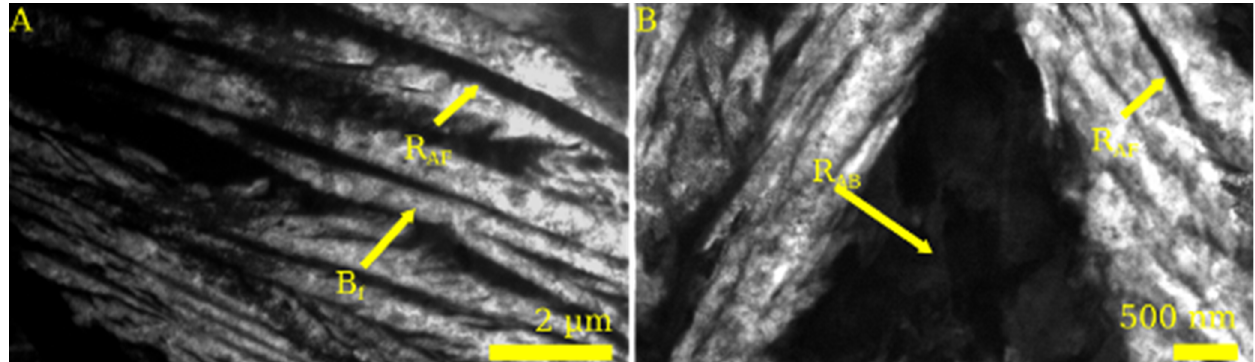
Figure 8. TEM micrographs on the samples treated according to MULTISTEP3 route ( A ) Bainitic sheave, ( B ) Retained austenite block between bainitic sheaves.